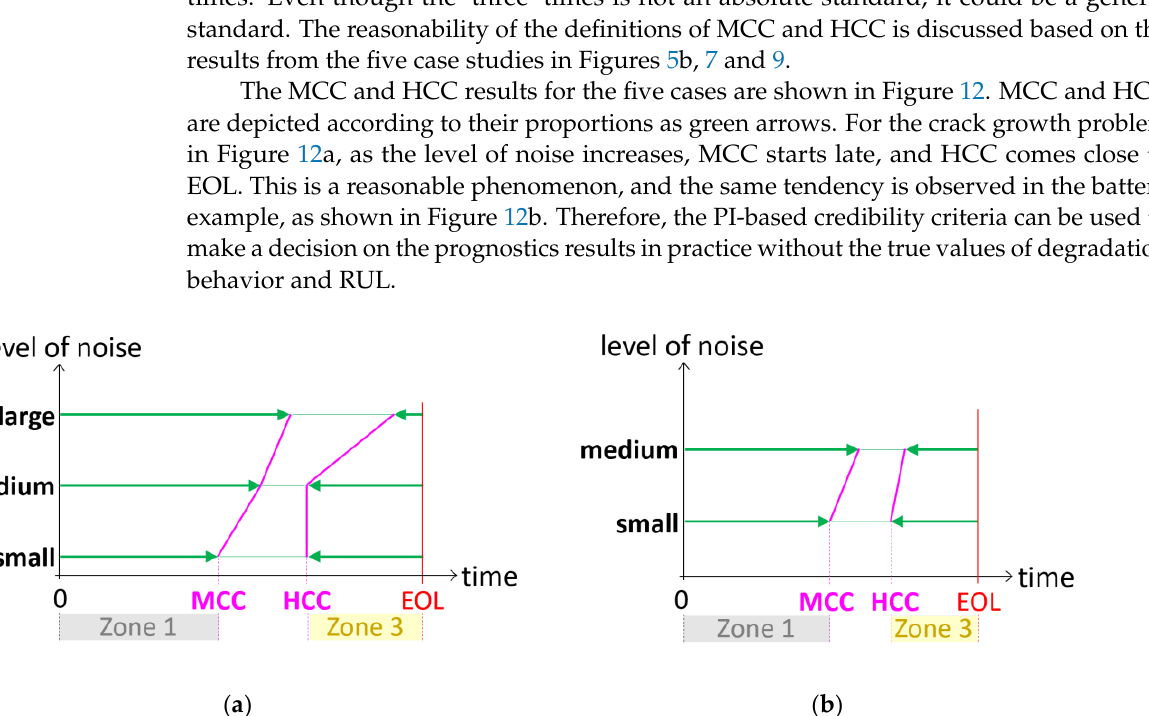
Figure 11. Changes of credibility criteria according to the level of noise. ( a ) Crack growth problem, ( b ) battery degradation problem.